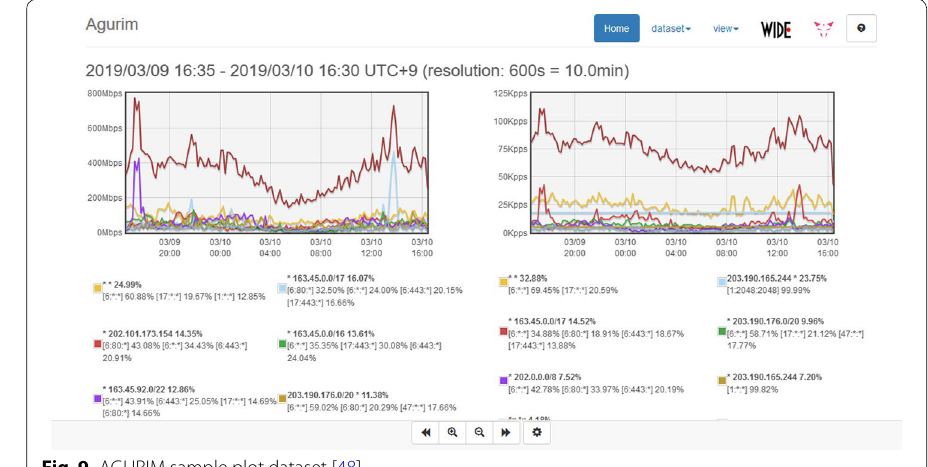
Fig. 9 AGURIM sample plot dataset [48]